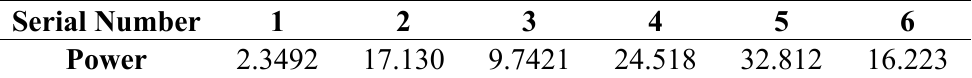
Table 4. Subsection power spectrum estimation of engineering signals ( × 10 4 ).